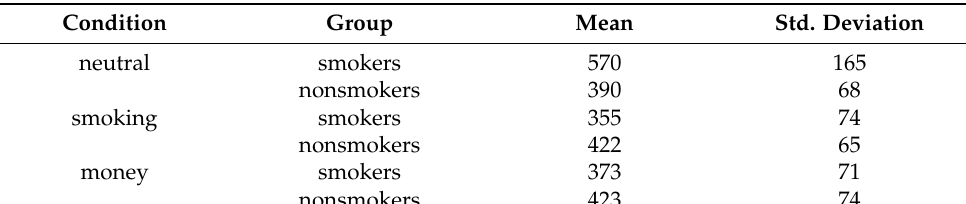
Figure 2. Mean proportion of inhibitions (the number of successful non-responses to no-go stimuli divided by the total number of no-go trials) for the smoker and nonsmoker groups across the neu- tral, smoking, and money conditions. Error bars indicate +/ − 2 standard errors from the mean.